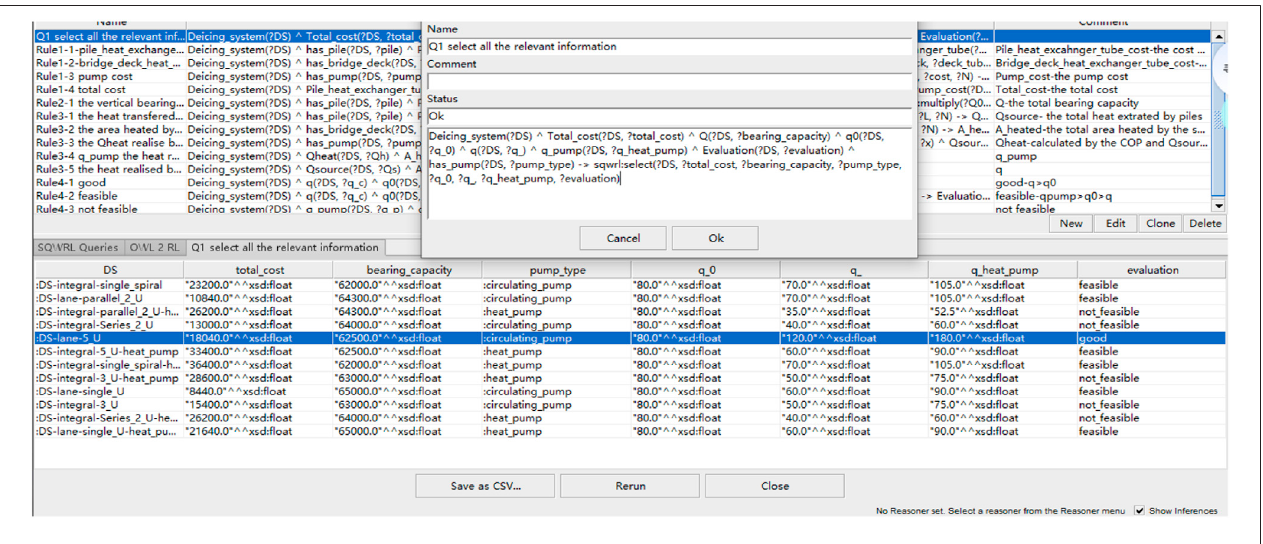
FIGURE 11 | Execution and results of querying Table 7 .